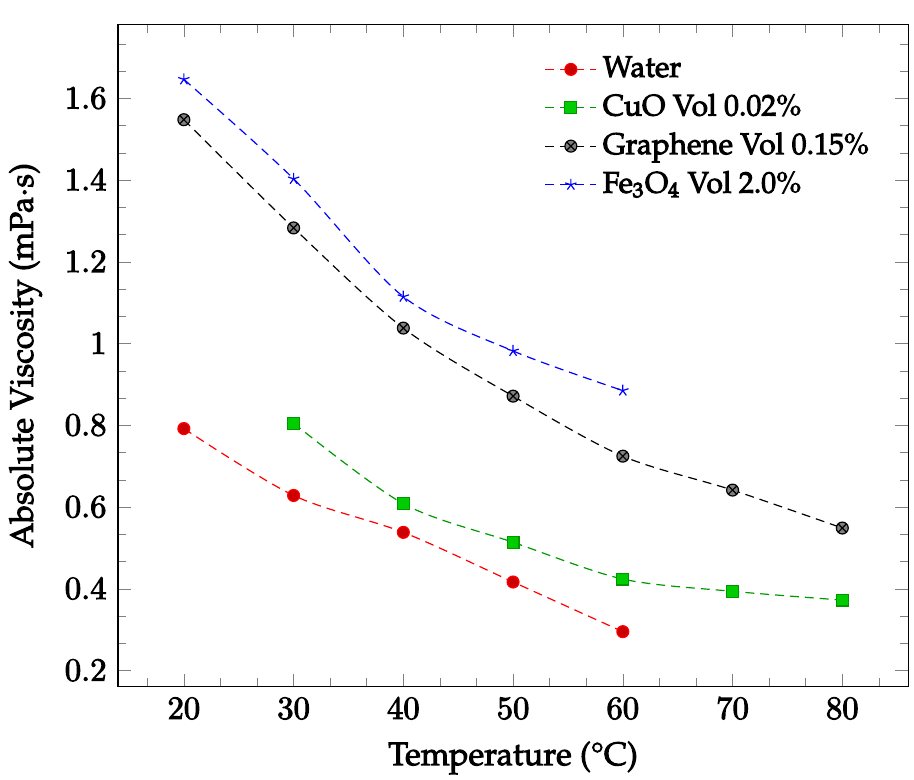
Figure 4. Nanofluid viscosity as a function of temperature for water-based fluids of 0.02% by weight CuO [34], 0.15% by volume graphene [35], and 2.0% by volume Fe 3 O 4 [15].